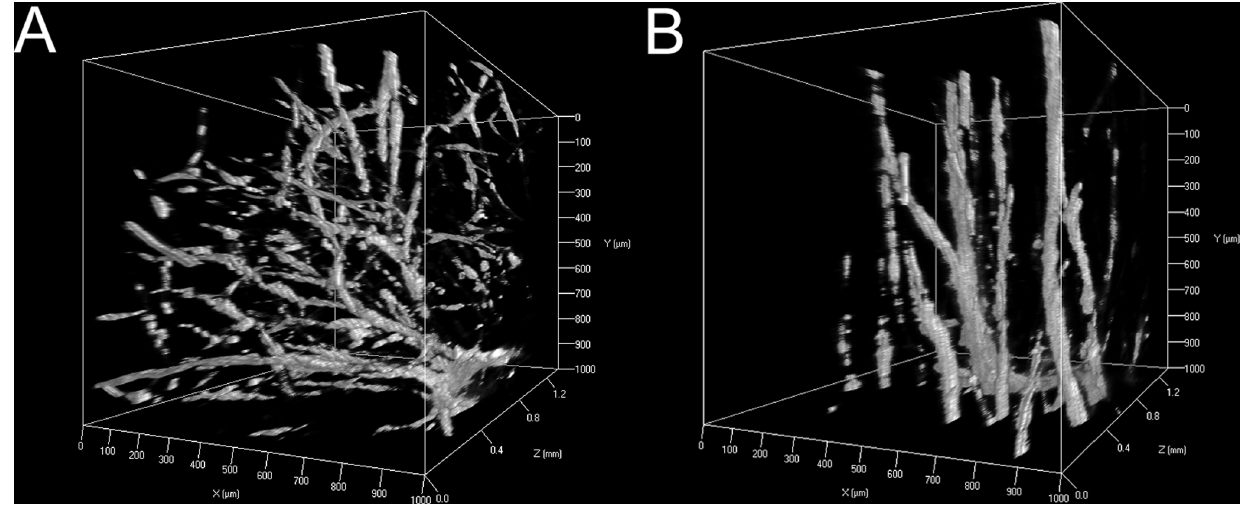
Figure 7. Three-dimensional vascular sprout invasion in PEG Scaffolds. 3D fluorescent image reconstructions of vascular sprout invasion in (A) bulk control gels and (B) PBFP gradient hydrogels taken at 10 6 magnification (Note: the gradient runs in the y-direction in